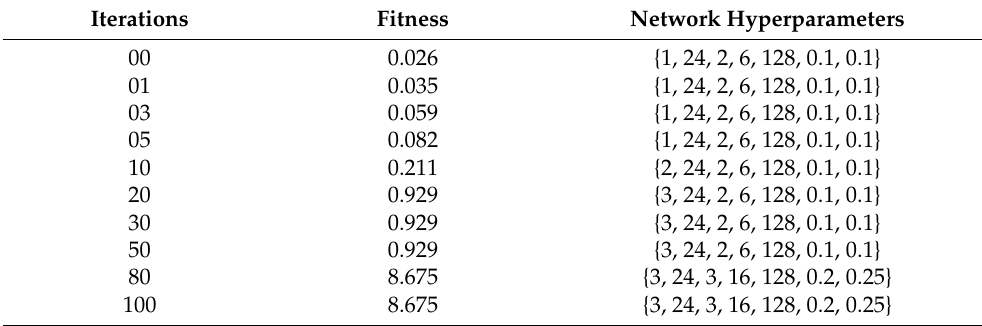
Table 12. The variations of fitness and corresponding network hyperparameters in dataset 2. Iterations